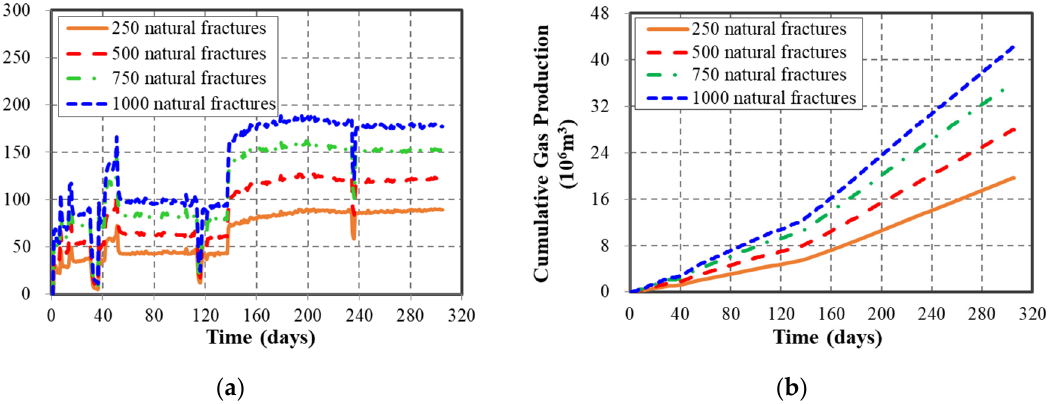
Figure 8. Production with different natural fracture numbers: ( a ) gas flow rate; ( b ) cumulative gas production.